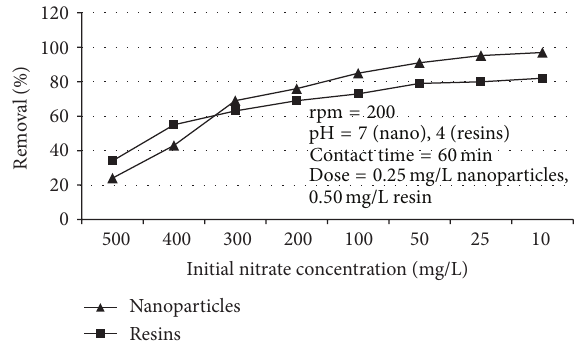
Figure 6: Effect of initial nitrate concentration and its removal by resin and Fe/Pt bimetallic nanoparticles.